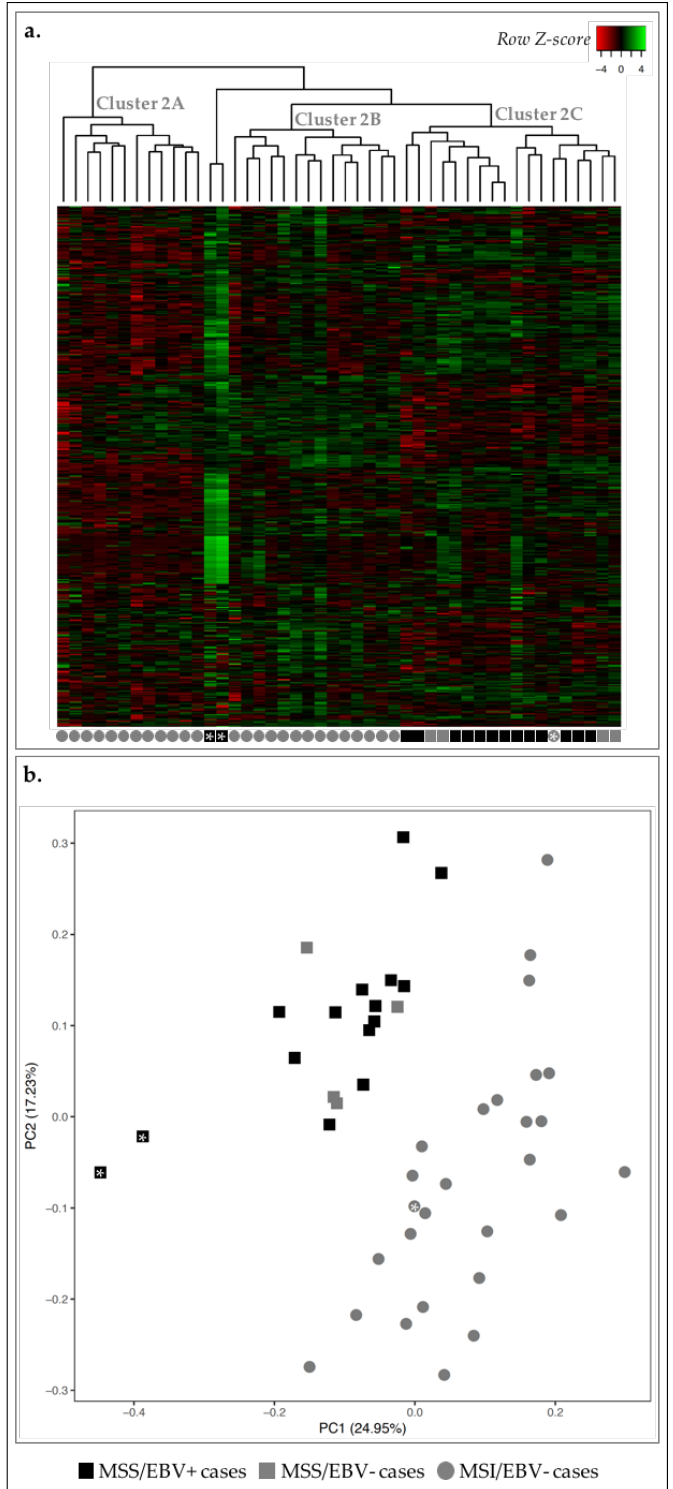
Figure 2. Transcription profile of 46 GC cases for 499 genes in the Nanostring CodeSet. Asterisks are used for cross-reference between the two figures and as links to the main text. ( a ) Heatmap for the expression of all genes in all GC cases (log 2 and Z -score scaled). Indicated are three main clusters: 2A – C. ( b ) PCA for principal components 1 and 2 for the 46 GC samples. Black squares correspond to MSS/EBV+ cases ( n = 15), gray squares to MSS/EBV − cases ( n = 4), gray circles to MSI-high /EBV− cases ( n = 27).